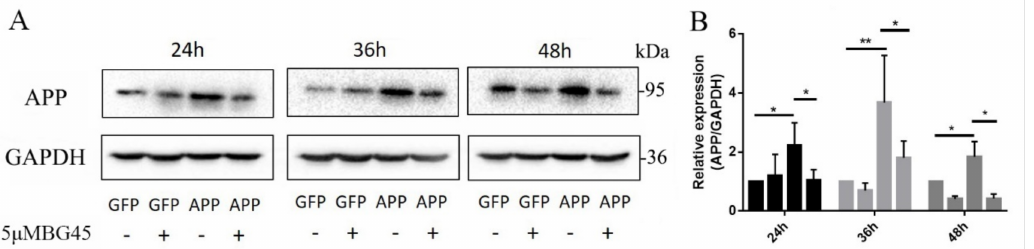
Figure 4. Effects of BG45 on the levels of APP. ( A ) Immunoblot analysis of APP levels in GFP- and APPsw-positive cells treated with vehicle or BG45 (15 µ M). ( B ) Quantification of APP levels. Significant differences were determined using Student’s t -test. All values are presented as the means ± SD from three independent experiments. * p < 0.05, ** p <